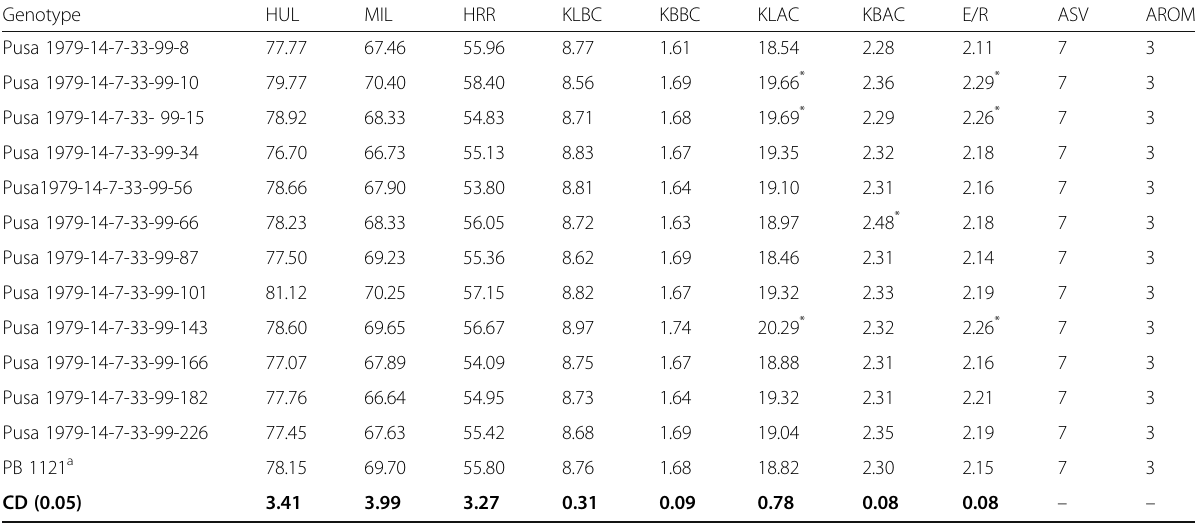
Table 6 Grain quality traits of PB 1121 HT-NILs in comparison to PB 1121